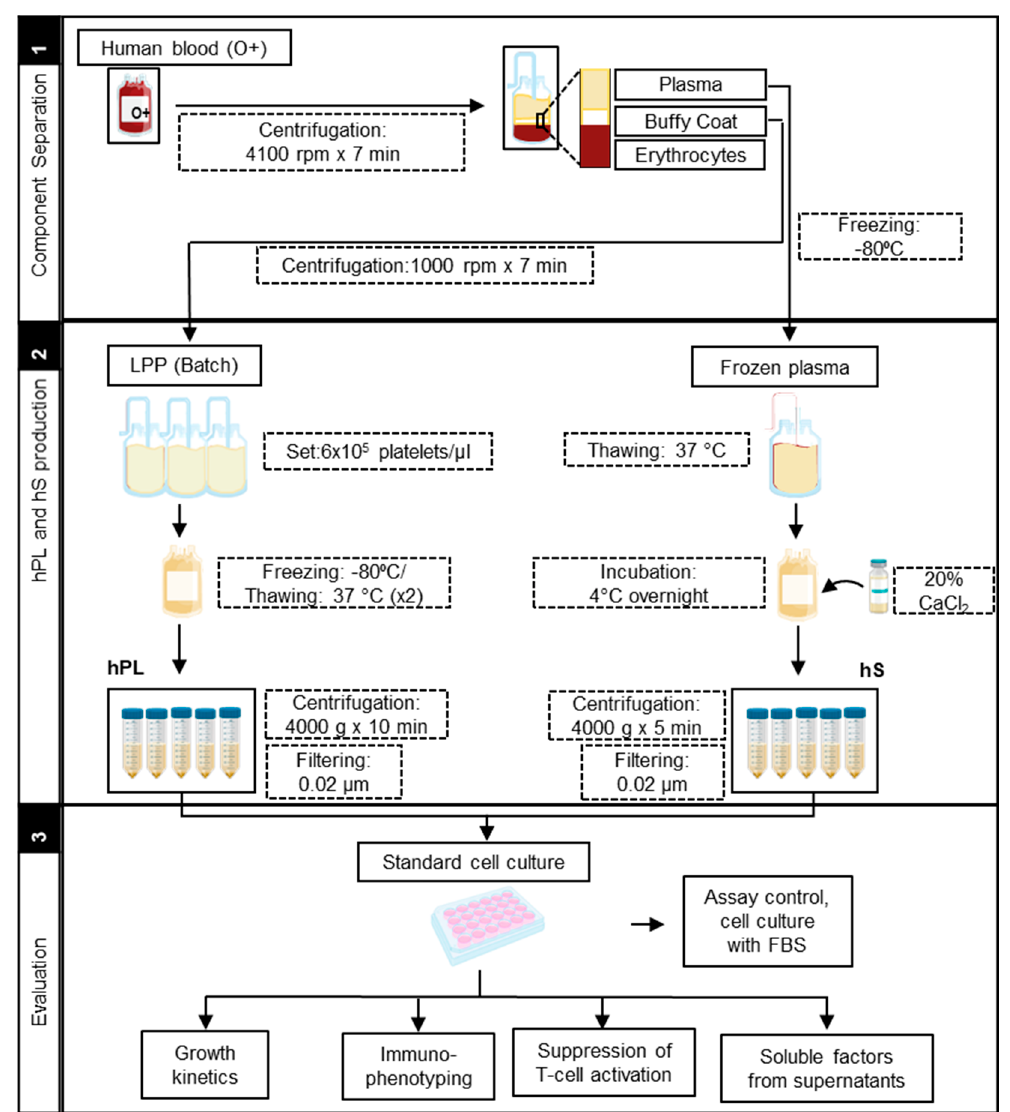
Figure 1. Manufacturing protocol scheme of human platelet lysate (hPL) and human serum (hS).